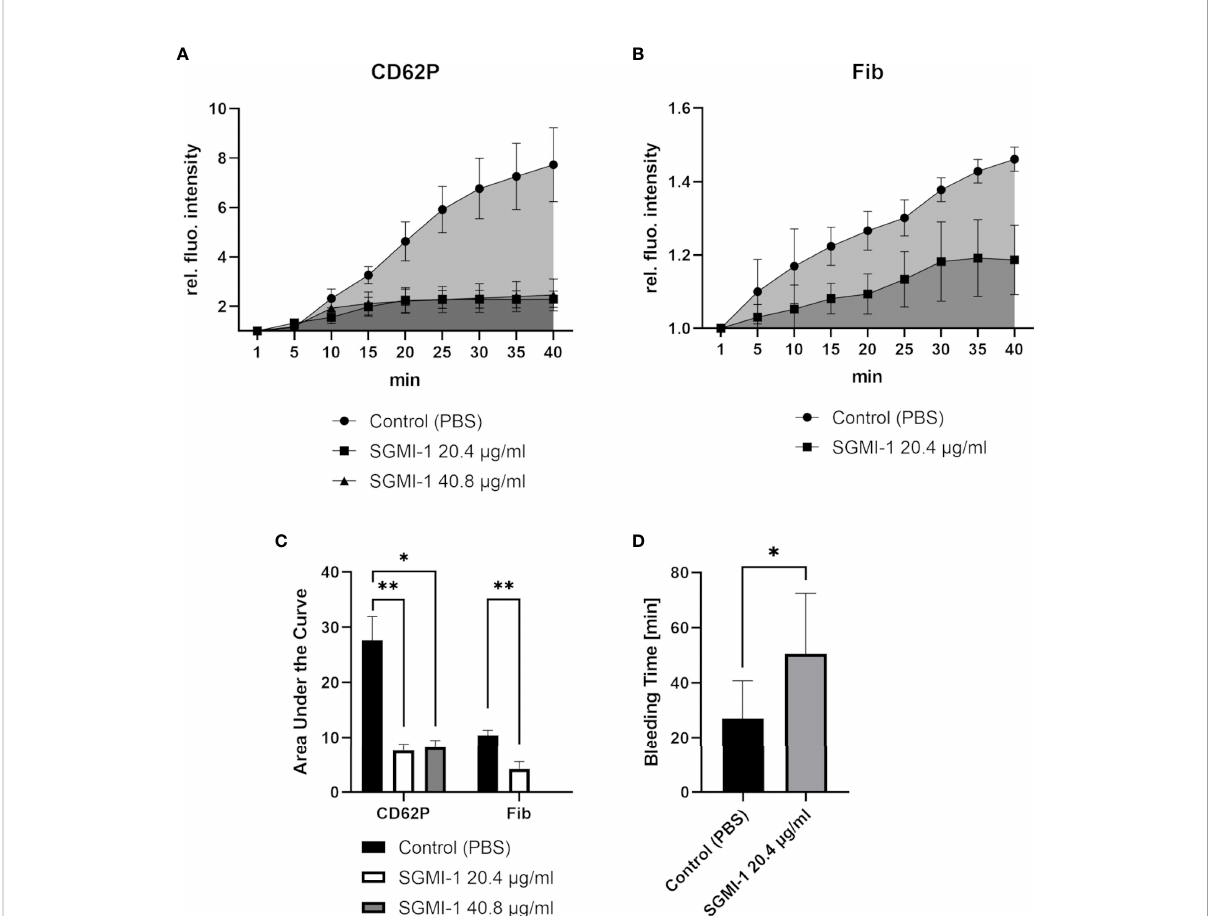
FIGURE 7 Effects of MASP-1-inhibition in the bleeding model. To investigate the effects of the MASP-1 inhibitor SGMI-1, the signal intensity relative to the fi rst time point was monitored for activated platelets (CD62P) (A) and fi brin (B) . A) Both concentrations of SGMI (20.4 m g/ml; n=4 and 40.8ug/ml; n=2) resulted in a reduced increase of the CD62P signal in comparison to the control (n=6). B) Fibrin deposition was reduced in the presence of SGMI-1 (n=3). The area under the curve (C) was measured using GraphPad Prism. (D) SGMI-1 prolonged the bleeding time (n=3). Data are shown as mean with SD, and p-values for differences between groups were determined with ANOVA or t-test (* p ≤ 0.05, ** p ≤ 0.01, *** p ≤